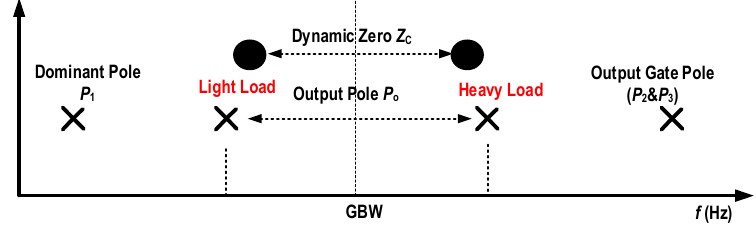
Figure 6. The location of the poles of the proposed regulation circuit.